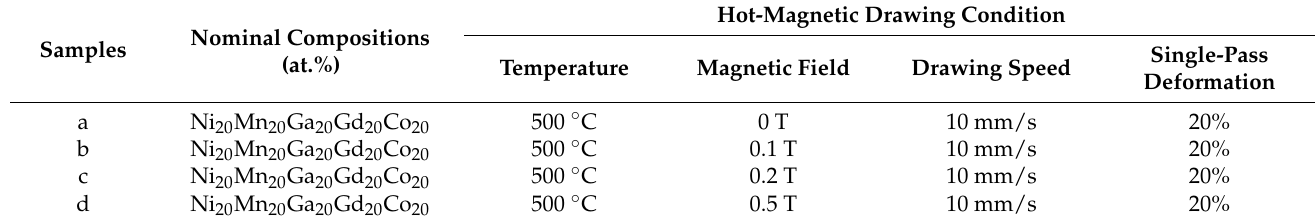
Table 1. The different hot-magnetic drawing conditions of samples. Hot-Magnetic Drawing Condition Nominal Compositions Samples (at.%) Temperature Magnetic Field Drawing Speed